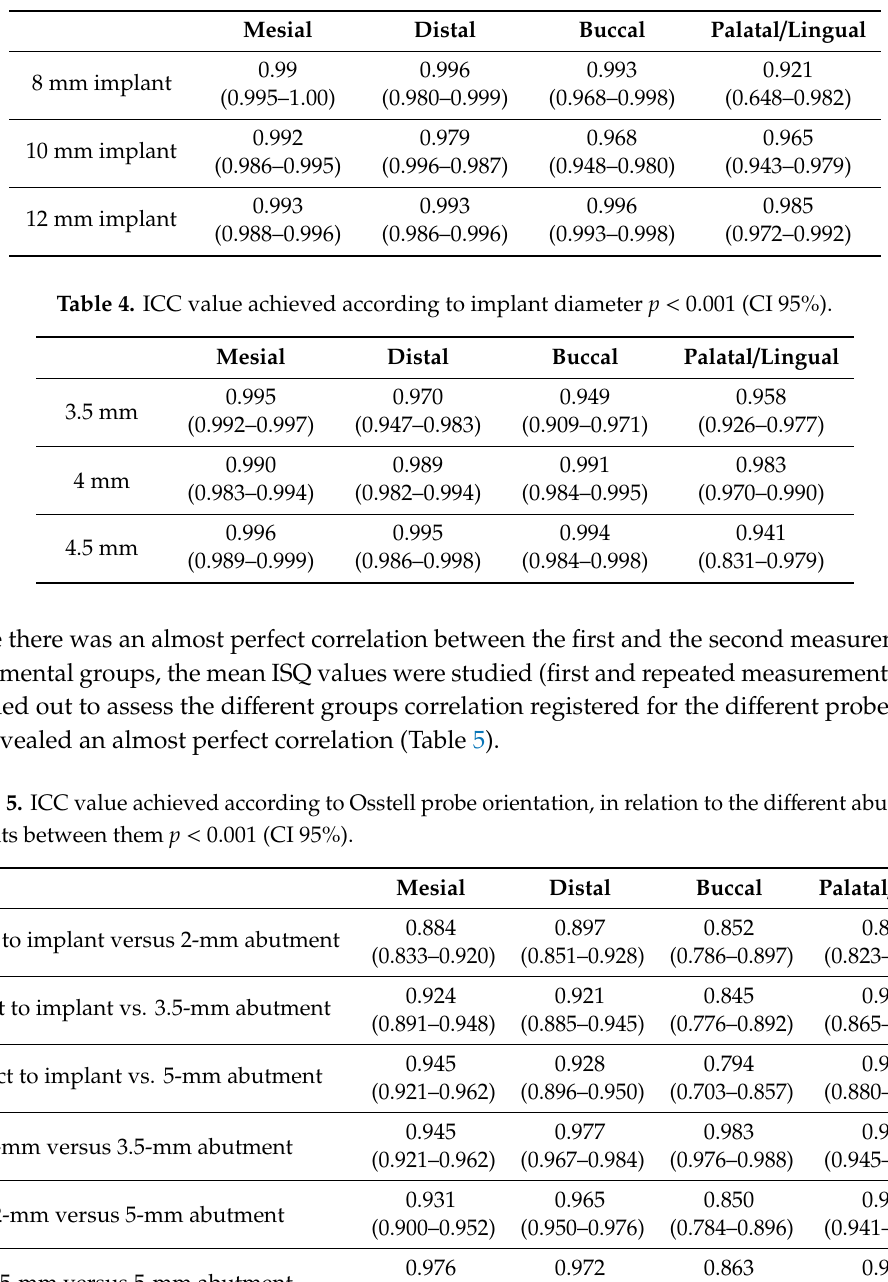
Table 3. ICC value achieved according to implant length p < 0.001 (CI 95%).